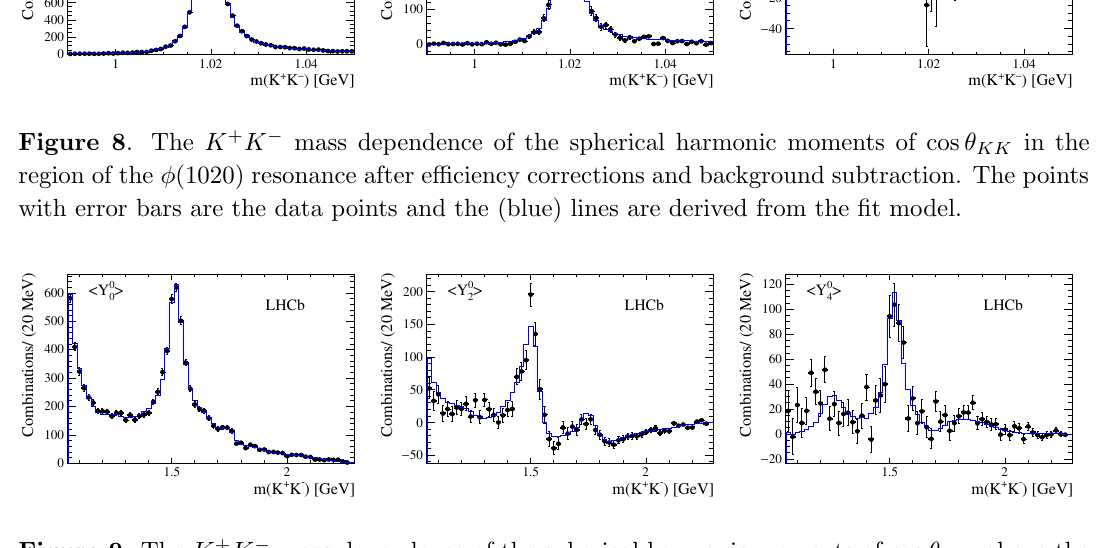
Figure 9 . The K + K (cid:0) mass dependence of the spherical harmonic moments of cos (cid:18) KK above the (cid:30) (1020) resonance region after e(cid:14)ciency corrections and background subtraction. The points with error bars are the data points and the (blue) lines are derived from the (cid:12)t